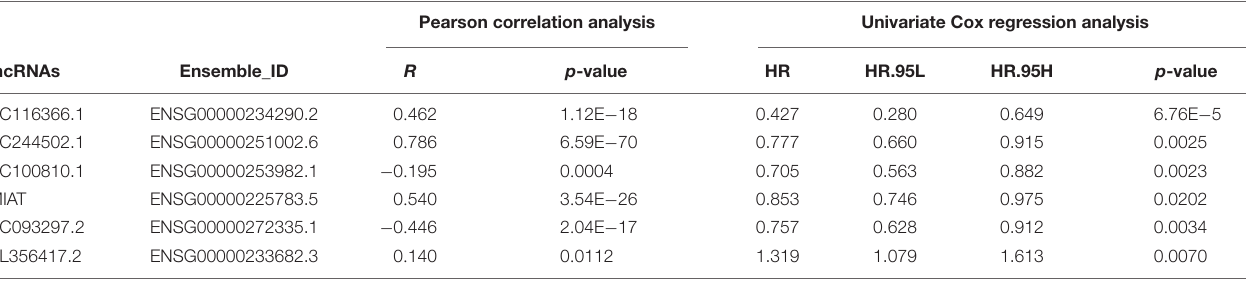
TABLE 1 | Six immune-related lncRNAs of the prognostic signature.